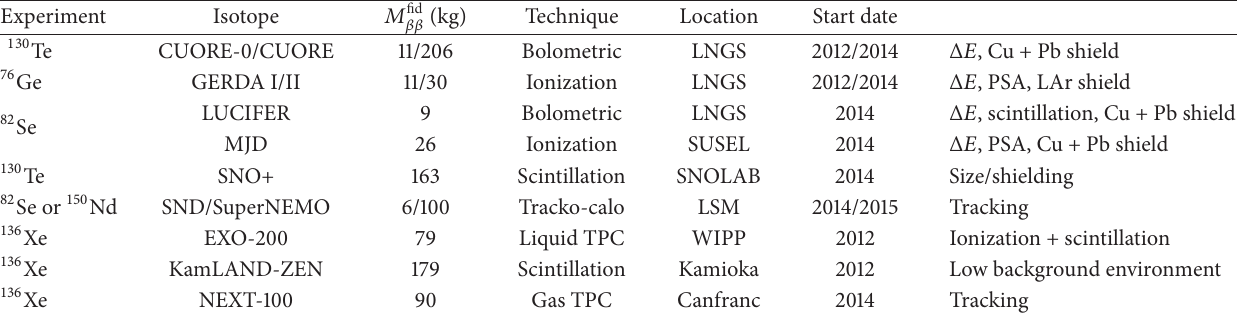
Table 5: A selected list of the next generation 𝛽𝛽(0 ] ) experiments. Important features that characterize each experiment are indicated in the last column: Δ𝐸 refers to a good energy resolution while pulse shape analysis (PSA) stands for the capability to discriminate events topologies. The isotope mass, 𝑀 fid 𝛽𝛽 , reported here takes into account isotopic abundance and fiducial volume as described in Sections